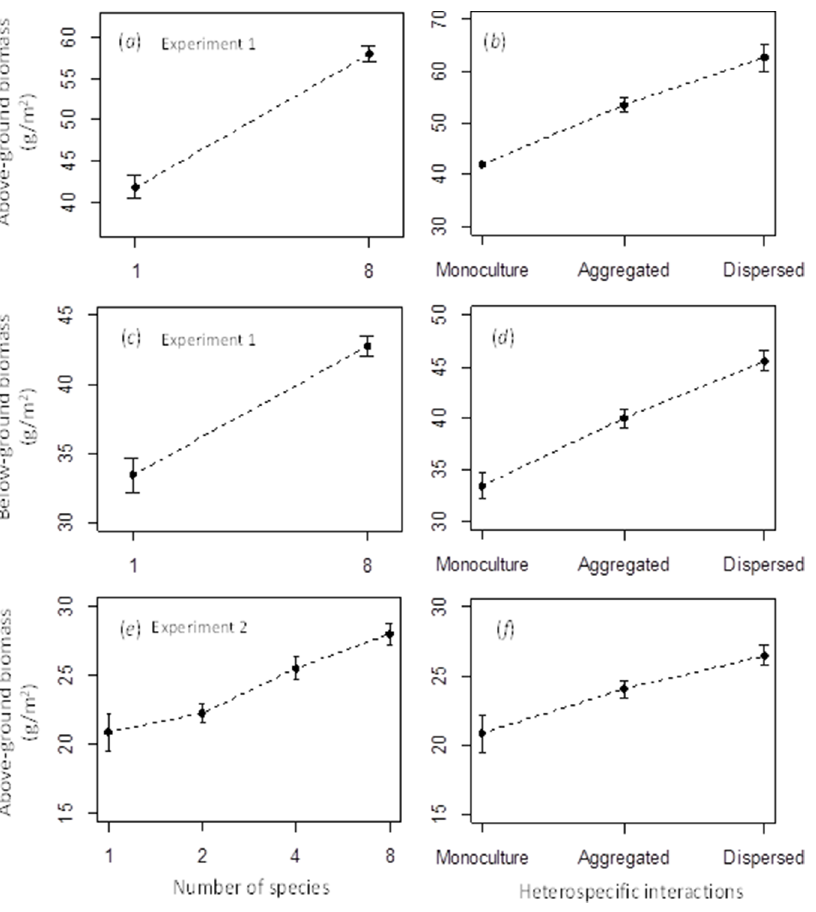
Figure 2. Effects of the number of species and heterospecific interactions on above- and belowbiomass. Mean 6 SE for the Box-Cox transformed above-ground biomass ( a and b ) and below-ground biomass ( c and d ) of experiment I and for the Box-Cox transformed above-ground biomass for experiment II ( e and f ). The x -axis label on the left column is the number of species. Experiment I had 2 richness levels (1 and 8 species). Experiment II had four richness levels (1, 2, 4 and 8 species).